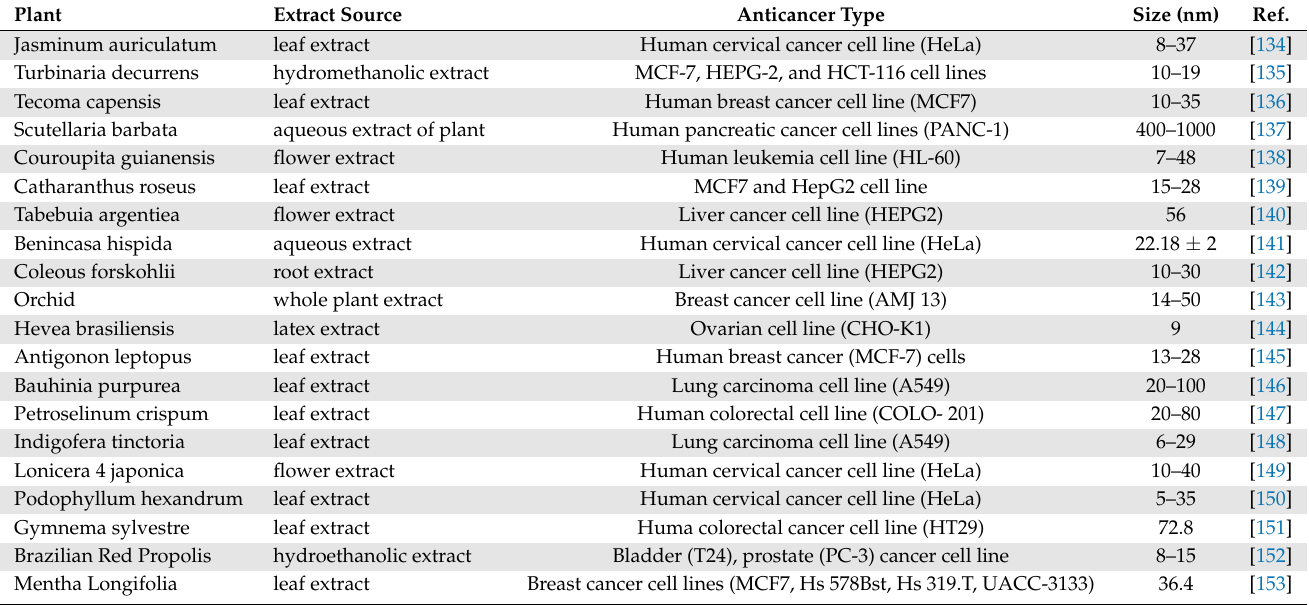
Table 2. Green synthesis of AuNPs using different bioagents and their